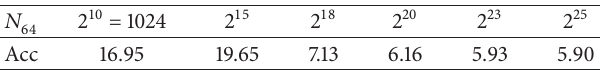
Table 3: The results of experiments (data are transferred through one 64-bit ACP high performance port and 𝜂 = 64 ).